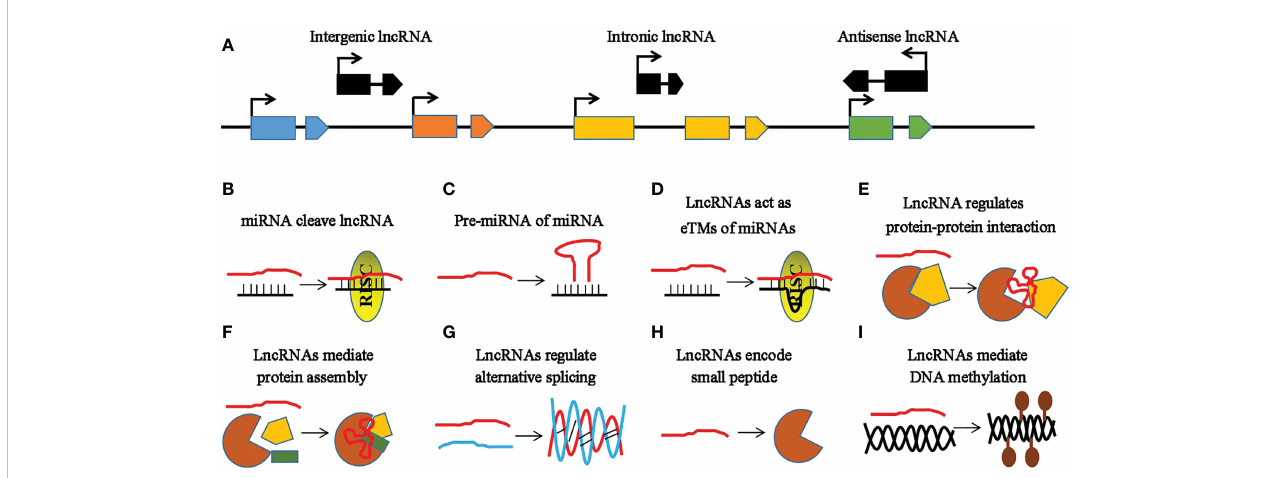
FIGURE 2 Characteristic features of long non-coding RNAs (lncRNAs). (A) Categories of lncRNAs based on their locations. The black line represents the chromosome, while the rectangles and polygons with similar colors represent the different exons of the protein-coding genes or lncRNAs. The blue , brown , yellow , and green rectangles and polygons represent different genes, while the black rectangles and polygons represent different lncRNAs. Intergenic , intronic , and antisense lncRNAs are the lncRNAs located outside the protein-coding genes, in the intron of a protein-coding gene, and those located in the antisense orientation to a protein-coding gene, respectively. Arrows indicate the direction of the gene or lncRNA. (B – I) Functional mechanisms of lncRNAs. The red line indicates the lncRNA, the black line represents the microRNA (miRNA), and the brown semicircle and yellow diagram indicate the proteins. (B) LncRNAs act as targets of miRNAs. (C) LncRNAs as precursor miRNAs (pre-miRNAs) of miRNAs. (D) LncRNAs as target mimics of miRNAs. (E) LncRNAs regulate protein – protein interactions. (F) LncRNAs as scaffolds regulating the assembly of protein complex subunits. (G) LncRNAs paired with their targeted RNAs. (H) LncRNAs encode small peptides. (I) LncRNAs contribute to epigenetic silencing via RNA-directed DNA methylation